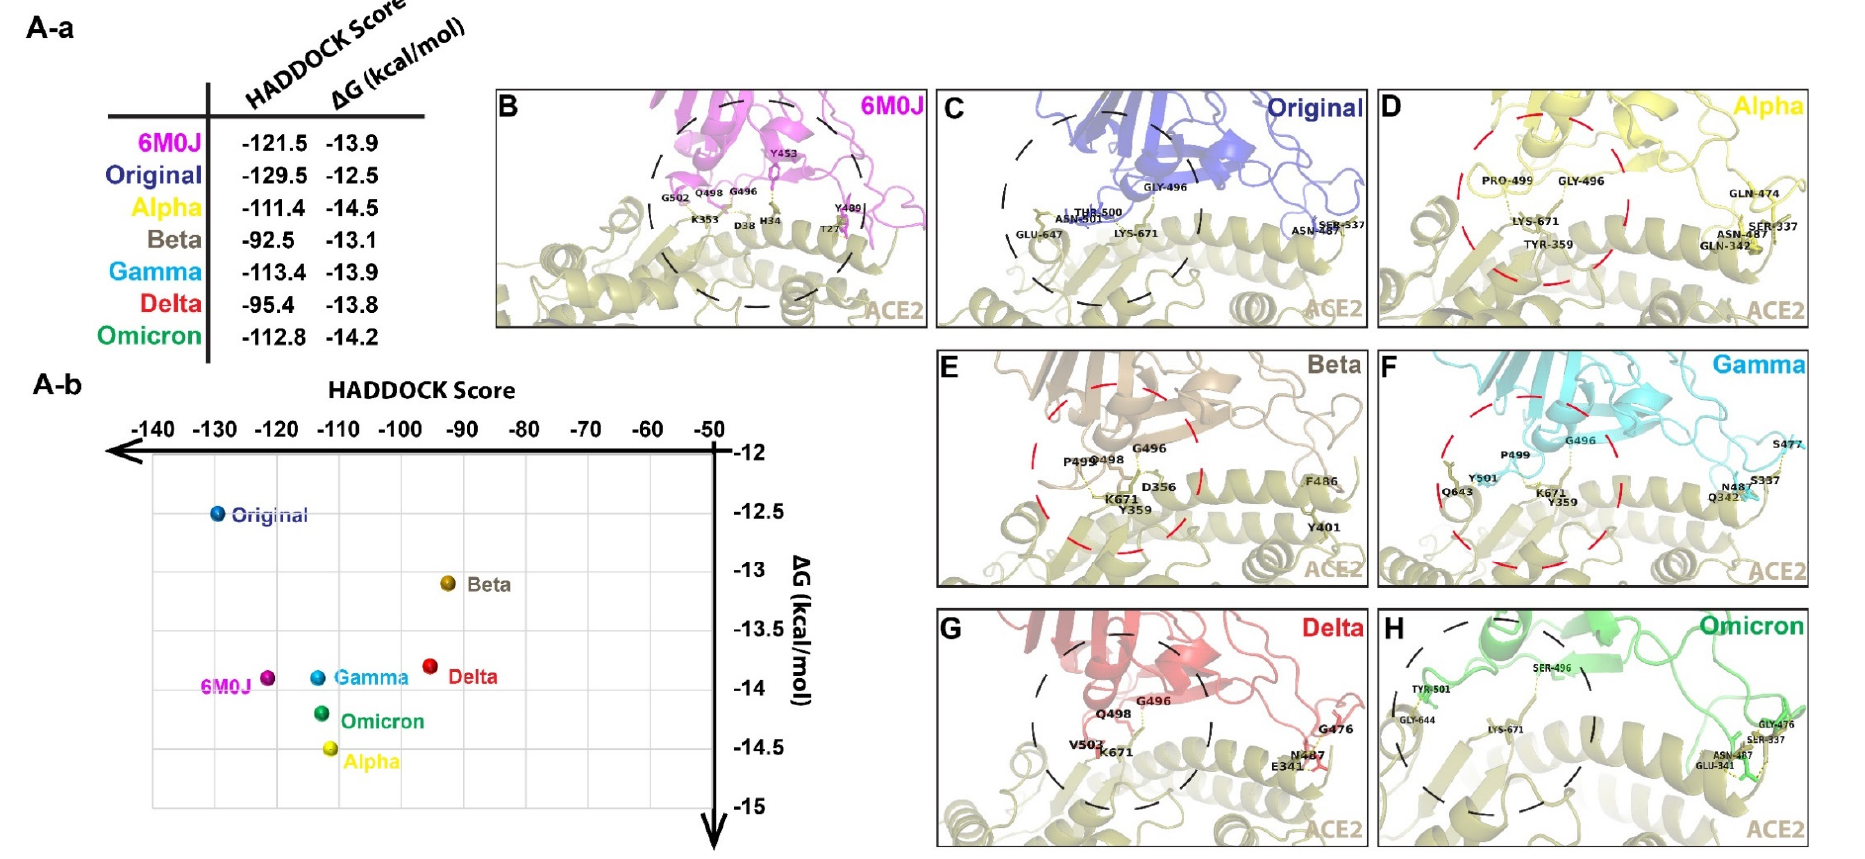
Figure 2. ( A-a )The HADDOCK and PRODIGY analysis of interactions between the naturally occurring variants’ RBDs and the ACE-2 receptor from 6M0J. ( A-b ) A distribution map of the scores obtained from HADDOCK and PRODIGY. ( B ) A cartoon representation of the interaction between 6M0J RBD and the ACE-2 receptor. ( C ) A cartoon representation of the interaction between the Original RBD and the ACE-2 receptor. ( D ) A cartoon representation of the interaction between the Alpha RBD and the ACE-2 receptor. ( E ) A cartoon representation of the interaction between the Beta RBD and the ACE-2 receptor. ( F ) A cartoon representation of the interaction between the Gamma RBD and the ACE-2 receptor. ( G ) A cartoon representation of the interaction between the Delta RBD and the ACE-2 receptor. ( H ) A cartoon representation of the interaction between the Omicron RBD and the ACE-2 receptor.